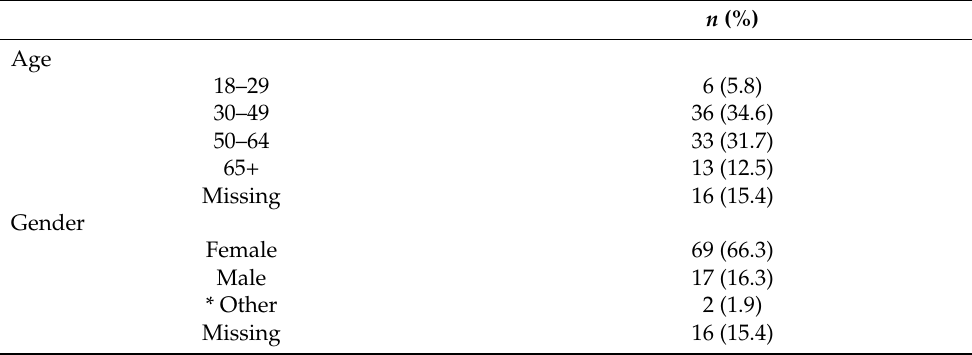
Table 2. Demographics of baseline participants ( n = 104).